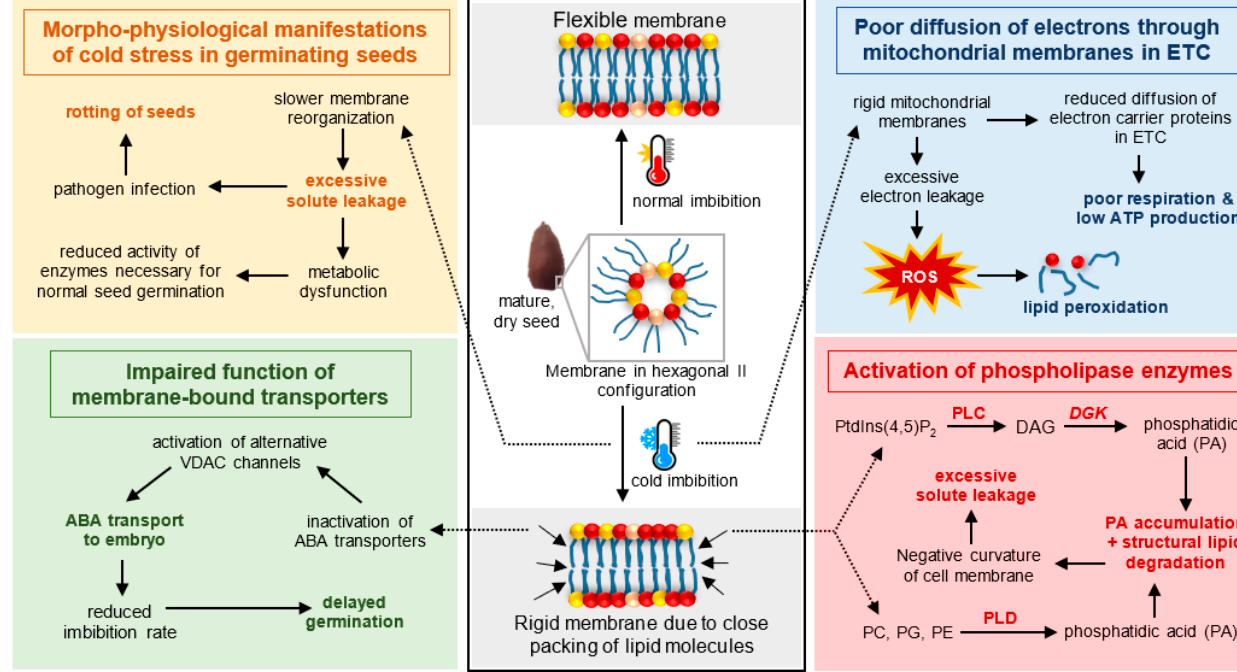
Figure 3. An overview of the seed responses to cold stress at the germination stage. Center panel illustrates the process of membrane reorganization from hexagonal II to lamellar configuration during water imbibition under cold and normal conditions. Cold-induced loss in membrane fluidity impairs the process of membrane reorganization and generated downstream responses, which has been explained at the physiological, biochemical and molecular level in the figure.